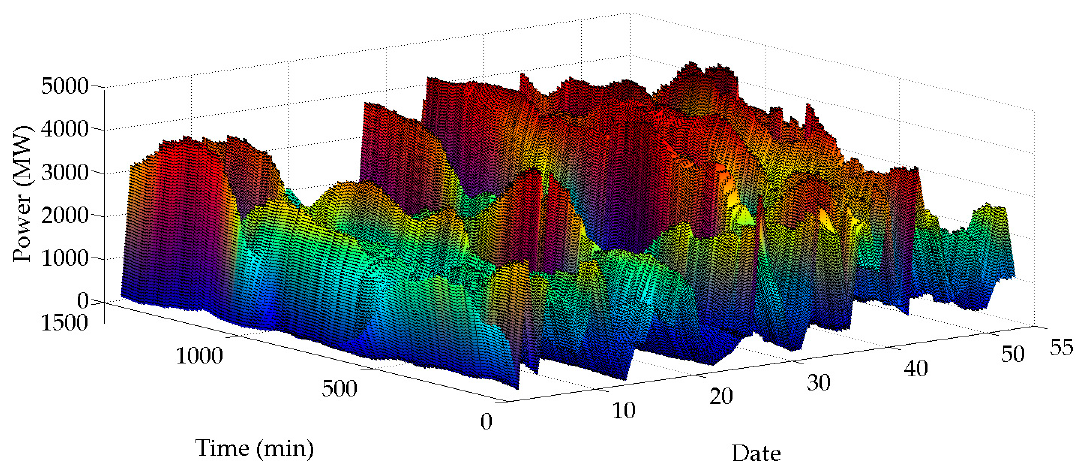
Figure 2. Actual wind power curve of one province from 3 March to 24 April.